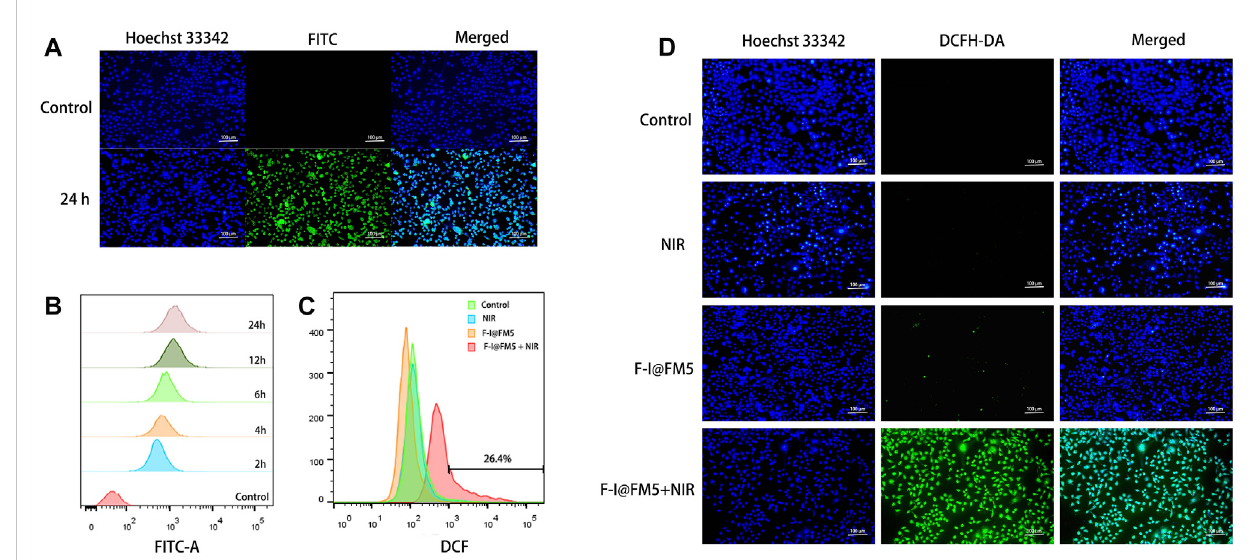
FIGURE 3 CelluptakeandROS generation ofF-I@FM5 invitro . (A) ObservationofintracellularFITCafter thenanoparticlesandEMT-6cellswereincubatedfor 24 h. (B) Flow data of intracellular FITC fl uorescence at different periods. (C) Flow data of intracellular DCF fl uorescence. (D) Observation of intracellular DCF in different groups (Scale bar equal to 100